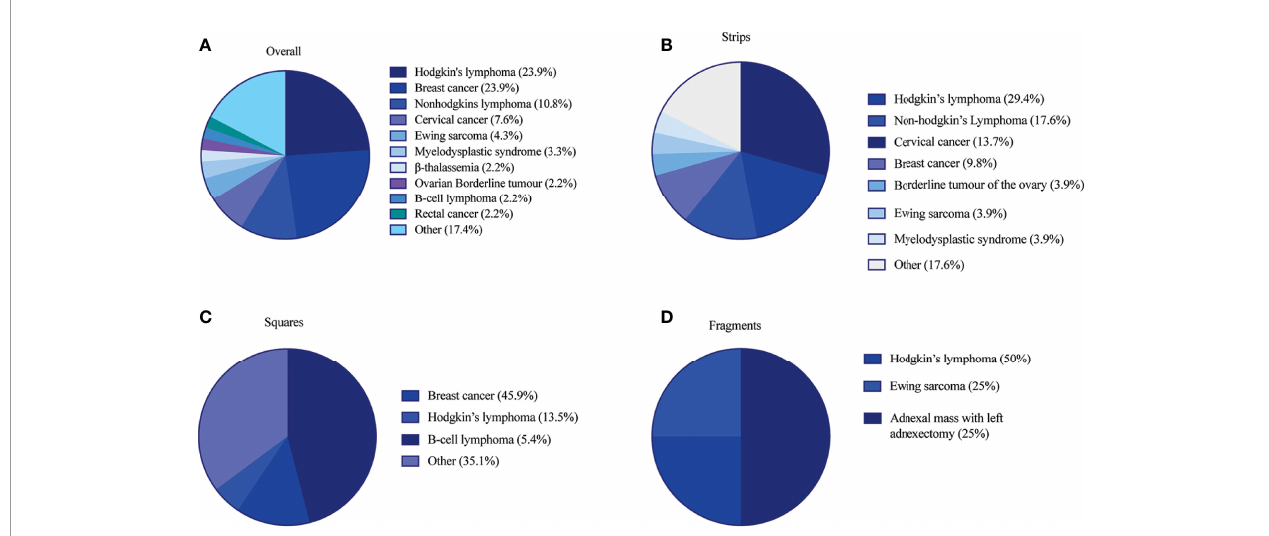
FIGURE 2 | Participant diagnosis at time of OTC in (A) overall patient population (B) strips (C) squares and (D) fragments group. Diagnoses in the other category included the following in (1) overall: acute lymphocytic leukemia, adnexal mass with left adnexectomy, aplastic anemia, autoimmune vasculitis, choriocarcinoma, colorectal cancer, endometrial cancer, granulomatosis with polyangiitis, leukemia, neuroendocrine tumor, ovarian cancer, Schwachman-diamond syndrome, sickle cell anemia, synovial sarcoma of the lung and pelvic sarcoma, systemic lupus erythematosus, T-cell lymphoma (2), strips: acute lymphocytic leukemia, aplastic anemia, b -thalassemia, colorectal cancer, endometrial cancer, rectal cancer, Schwachman-diamond syndrome, sickle cell anemia, systemic lupus erythematosus, and (3) squares: autoimmune vasculitis, b -thalassemia, choriocarcinoma, Ewing ’ s sarcoma, granulomatosis with polyangiitis, leukemia, myelodysplastic syndrome, neuroendocrine tumor, non-Hodgkin ’ s lymphoma, ovarian cancer, rectal cancer, synovial sarcoma of the lung and pelvic sarcoma, T-cell lymphoma (21, 22, 25, 34, 37, 44, 57, 59, 61, 64, 66, 78, 84, 91 – 93, 95, 111, 115, 118, 124).